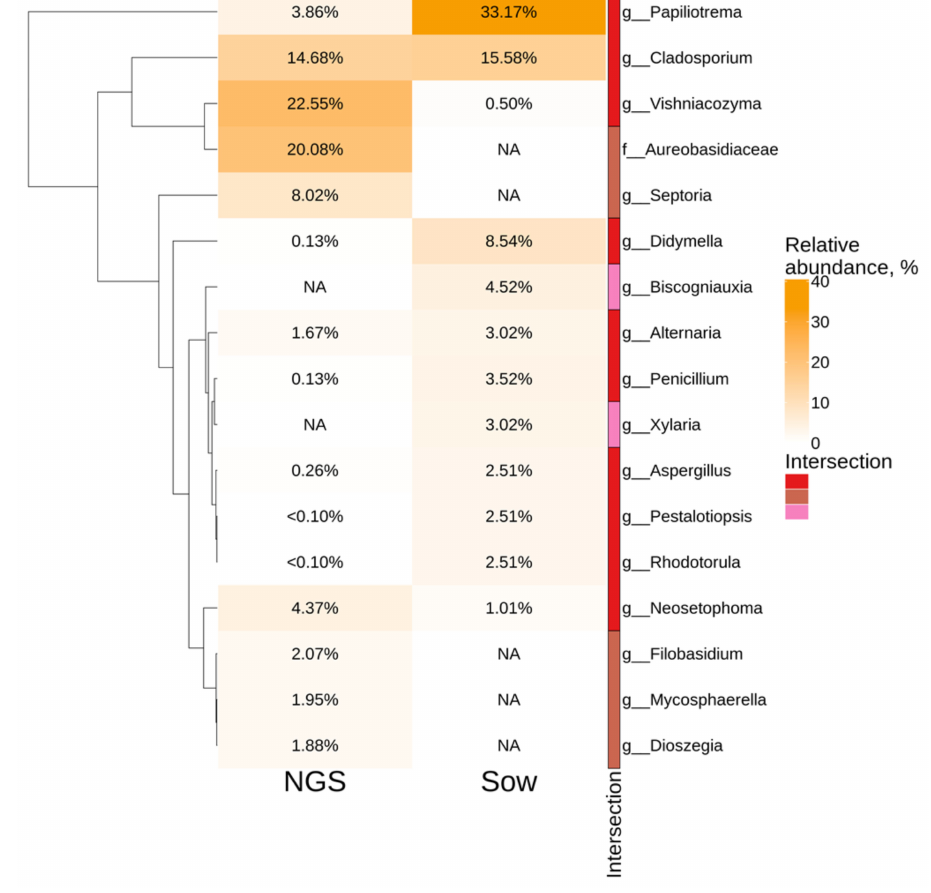
Figure 2. Genus level relative abundance heat maps of significant taxa in Vitis amurensis according to the cultivation-independent (next-generation sequencing (NGS)) and cultivation-dependent (fungal sowing (Sow)) methods. The top ten most abundant taxa from each factor are displayed. White squares (NA) represent the absence of taxa. The intersection selection was made based on the UpSet diagram in Supporting Information